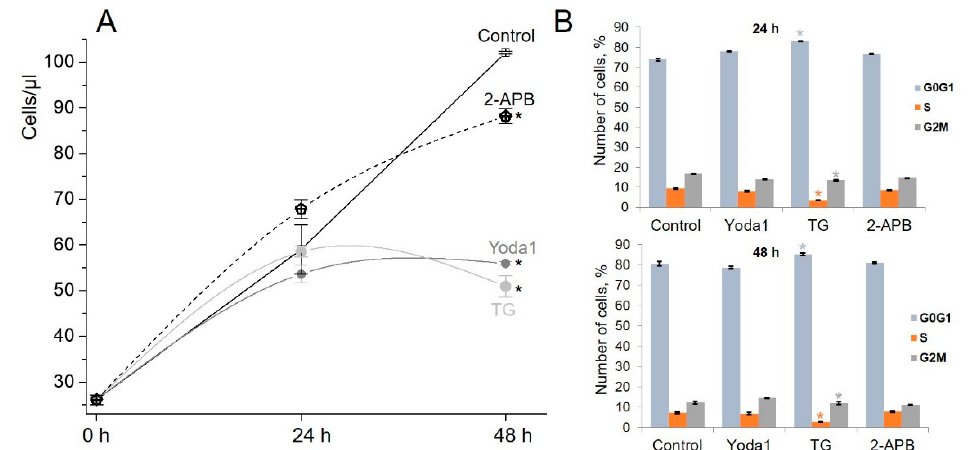
Figure 6. Impact of Yoda, TG and 2-APB treatment on eMSC proliferation and cell cycle distribution. ( A ) Growth curves of eMSCs in the presence of 5 µM 2-APB, 10 µM Yoda1 or 1 µM of TG. The data are presented as mean ± SD ( n = 3), * significantly different compared to control (Student’s t -test, p < 0.05). ( B ) The percentage of cells in the G0/G1, S and G2/M phases. The data are presented as mean ± SD ( n = 3), * significantly different compared to control (Student’s t -test, p < 0.05).